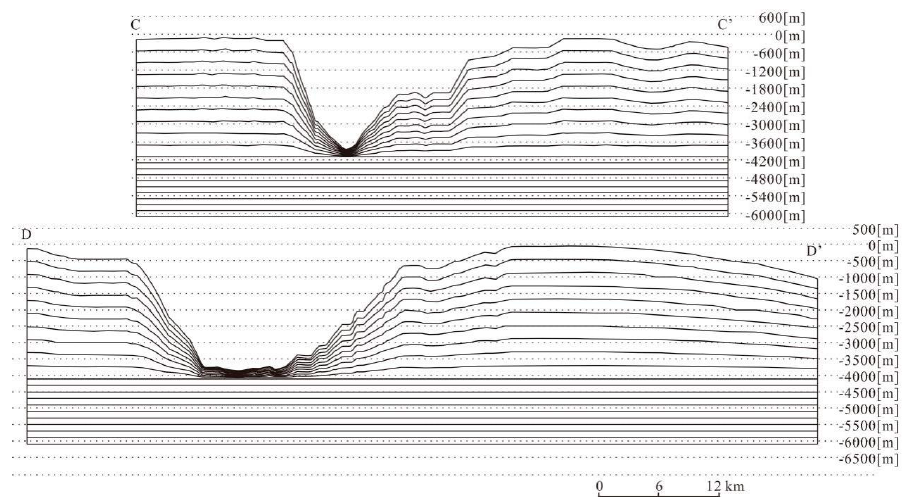
Figure 8. Sections showing layers of the geologic model, section locations are indicated in Figure 7.